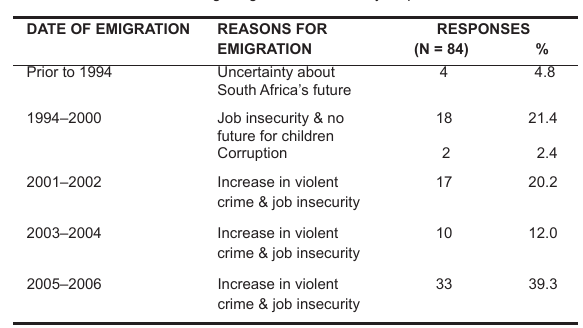
TABLE 3 Factors driving emigration: Web survey